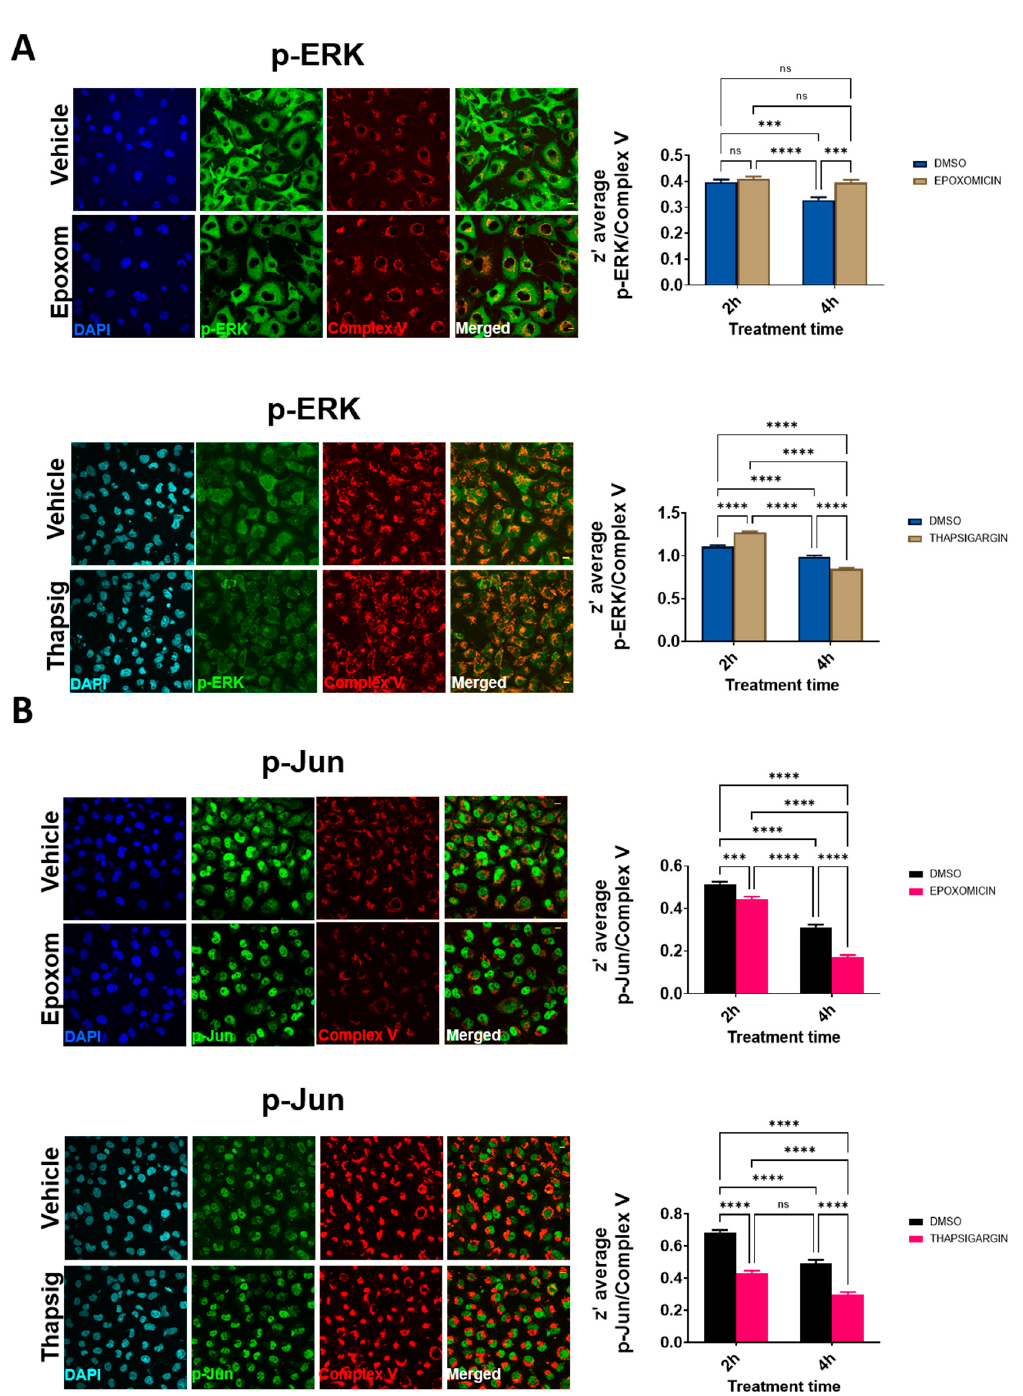
Figure 5. Proteasome and ER stress induces changes in the colocalization degree of p-ERK and p-Jun with mitochondrial epitopes. Representative confocal microscopy images of HMEC cells immunostained with antibodies against p-ERK and mitochondrial epitopes in ( A) and against p-Jun and mitochondrial epitopes in ( B ), showing diverse effects of proteasome inhibition (epoxomicin) and ER stress (thapsigargin) in the degree of colocalization estimated by calculation of the z’ factor (right panels). Images shown are for 2 h of incubation. Bars indicate mean with standard deviation shown by lines (n = 195 to 658 cells for p-ERK and n = 285–553 for p-Jun); *** indicate p < 0.001, and **** p < 0.0001 by Bonferroni’s post-hoc multiple comparison test after 2 way ANOVA. Bars in ( A , B ) micrographs are 20 micrometer long.